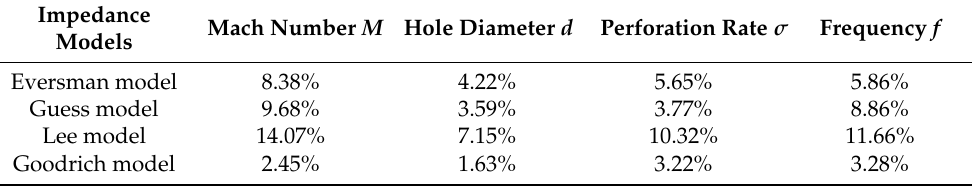
Table 1. Average relative errors of the predicted transmission loss using the IBNSE method under different parameter variations (Mach number, hole diameter, perforation rate and